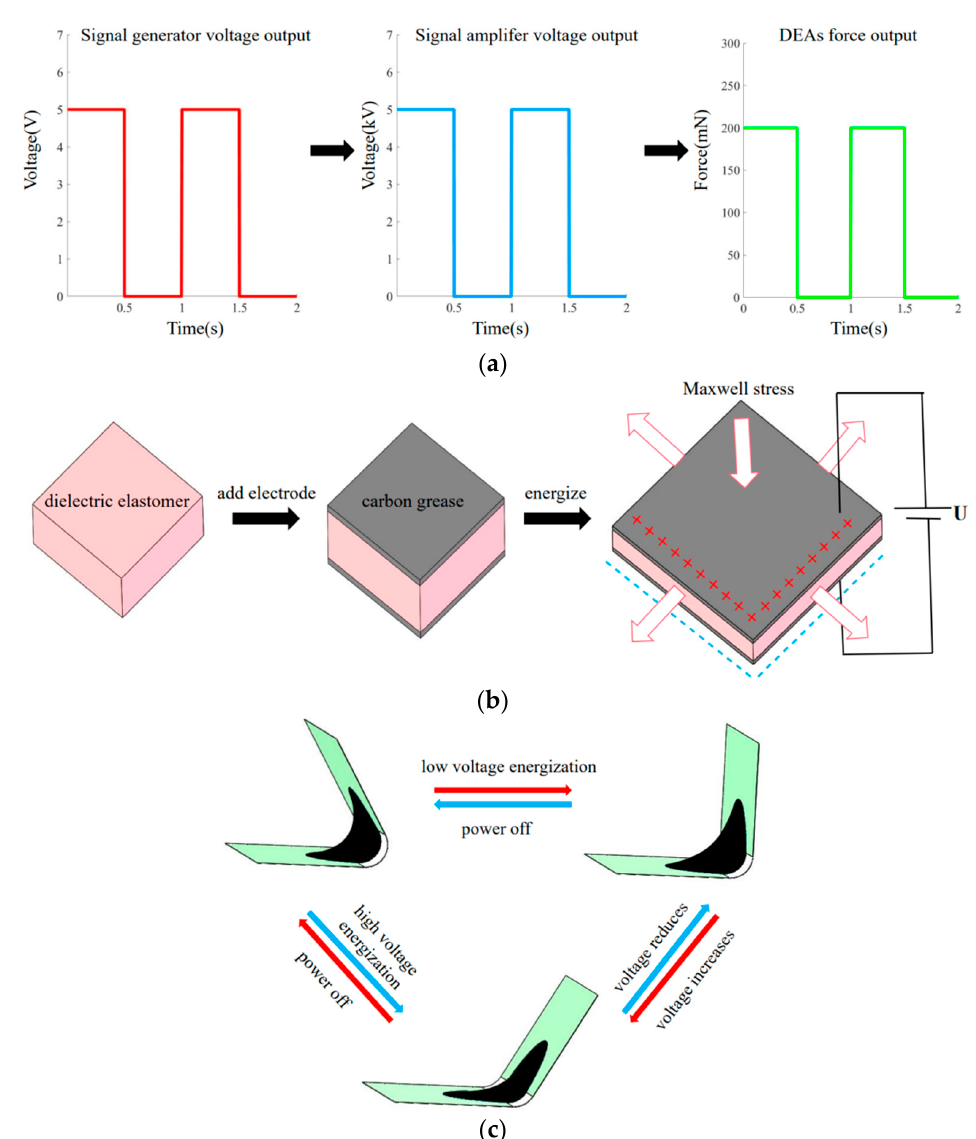
Figure 3. Periodic movement of actuator. ( a ) The transmission process of signal through voltage source, signal generator and voltage amplifier; ( b ) Actuation principle of dielectric elastomer; ( c ) Status of DEA under power on and power off.